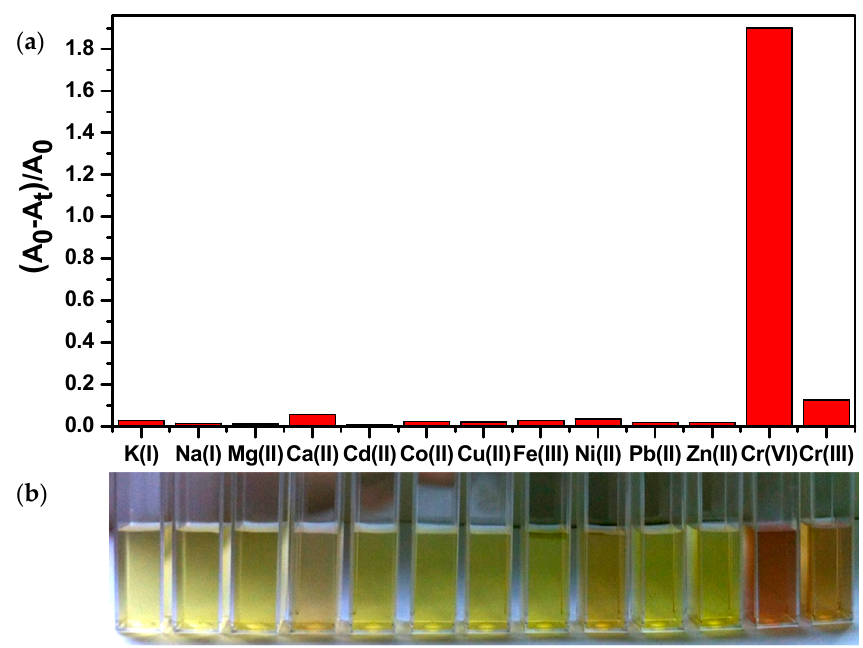
Figure 6. ( a ) Relative change of absorption band intensity of raffinose capped silver nanoparticles with the addition of different kinds of metal ions, including K(I), Na(I), Mg(II), Ca(II), Cd(II), Co(II), Cu(II), Fe(III), Ni(II), Pb(II), Zn(II), Cr(III) (concentration level at 50 μ mol L − 1 ), and Cr(VI) (concentration level at 5 μ mol L − 1 ) within a contact time of 5 min; ( b ) Digital images of corresponding mixtures.